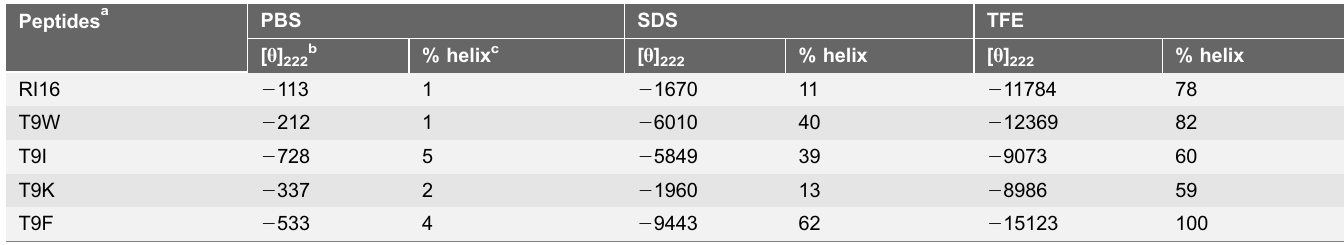
Table 2. CD data of the peptides. Peptides a